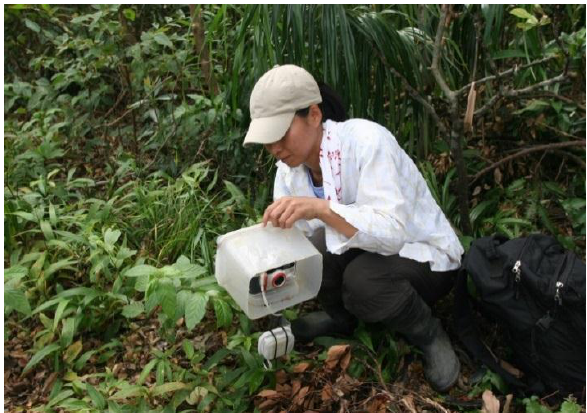
Figure 11. An automated photograph system with an infrared